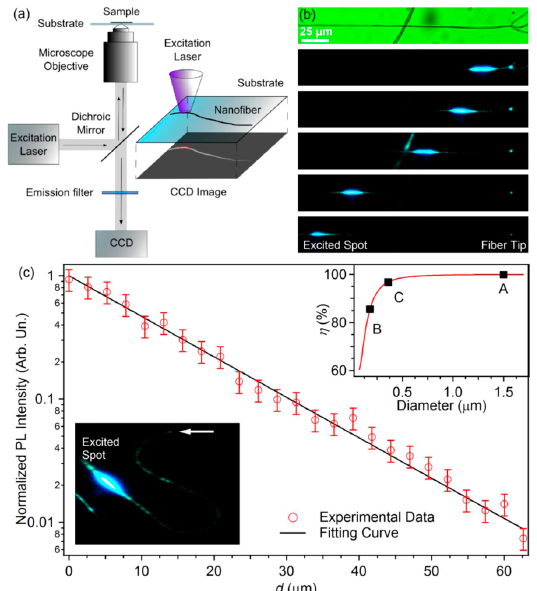
Figure 10. ( a ) Scheme of single-fiber waveguiding characterization setup. ( b ) Images of a fiber excited by a focused laser at different positions along the fiber. Top panel: brightfield image of the nanofiber. ( c ) Fluorescence intensity (red circles) versus guided distance d from the excitation spot to the fiber tip and the exponential fit. Bottom-left inset: micrograph of light guided in a bent polymer fiber. Right-top inset: fraction of guided power in fundamental mode versus fiber diameter. Points labeled A, B, and C correspond to the average diameter of fibers fabricated without additives (A) and with the addition of organic salts (B and C) (the whole Figure 10 was reprinted with permission from Fasano et al. [46]).